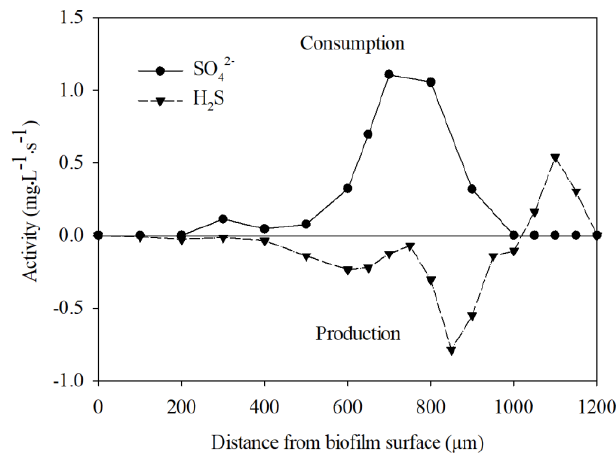
Figure 6. The net specific consumption and production rates of H 2 S and SO 42 − in the membrane-aerated biofilm (MAB) biofilm.